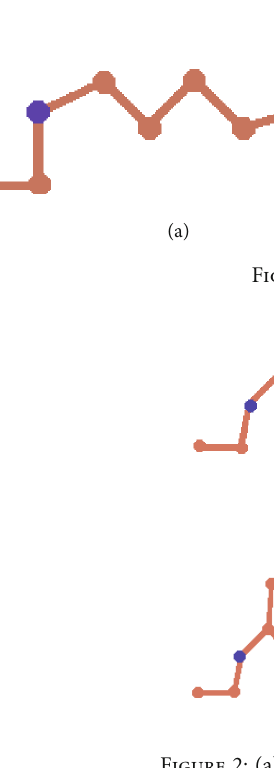
– II [1, 4] where i = 4 and j = 1 and (b) SiC Figure 2: (a) SiC 4